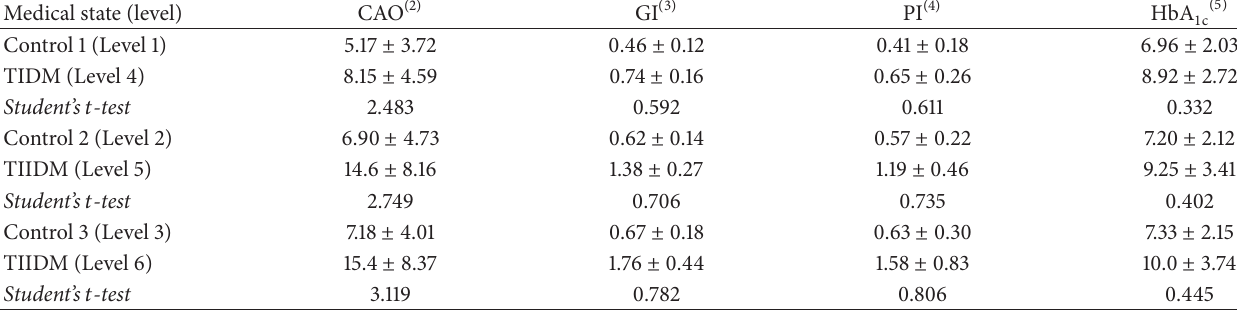
Table 2: Comparison of clinical variables in diabetic group versus